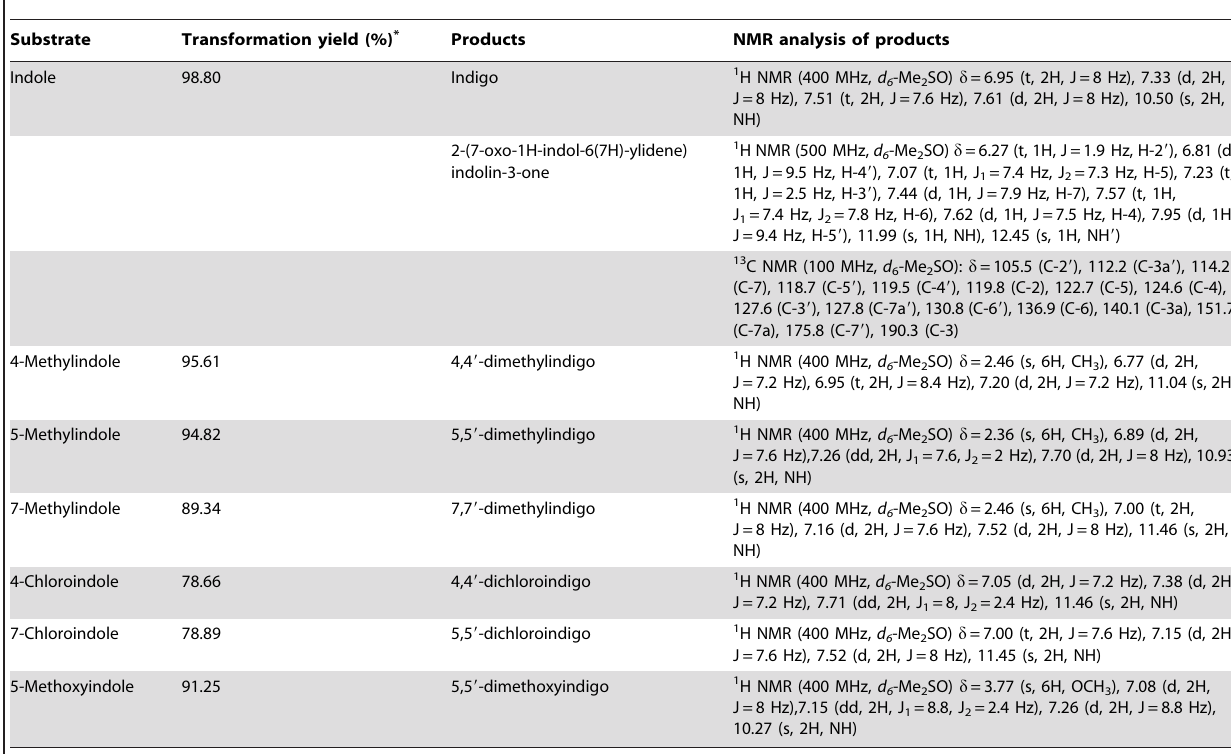
Table 1. Characteristics of indigoids produced by whole cells of strain PH_ IND .